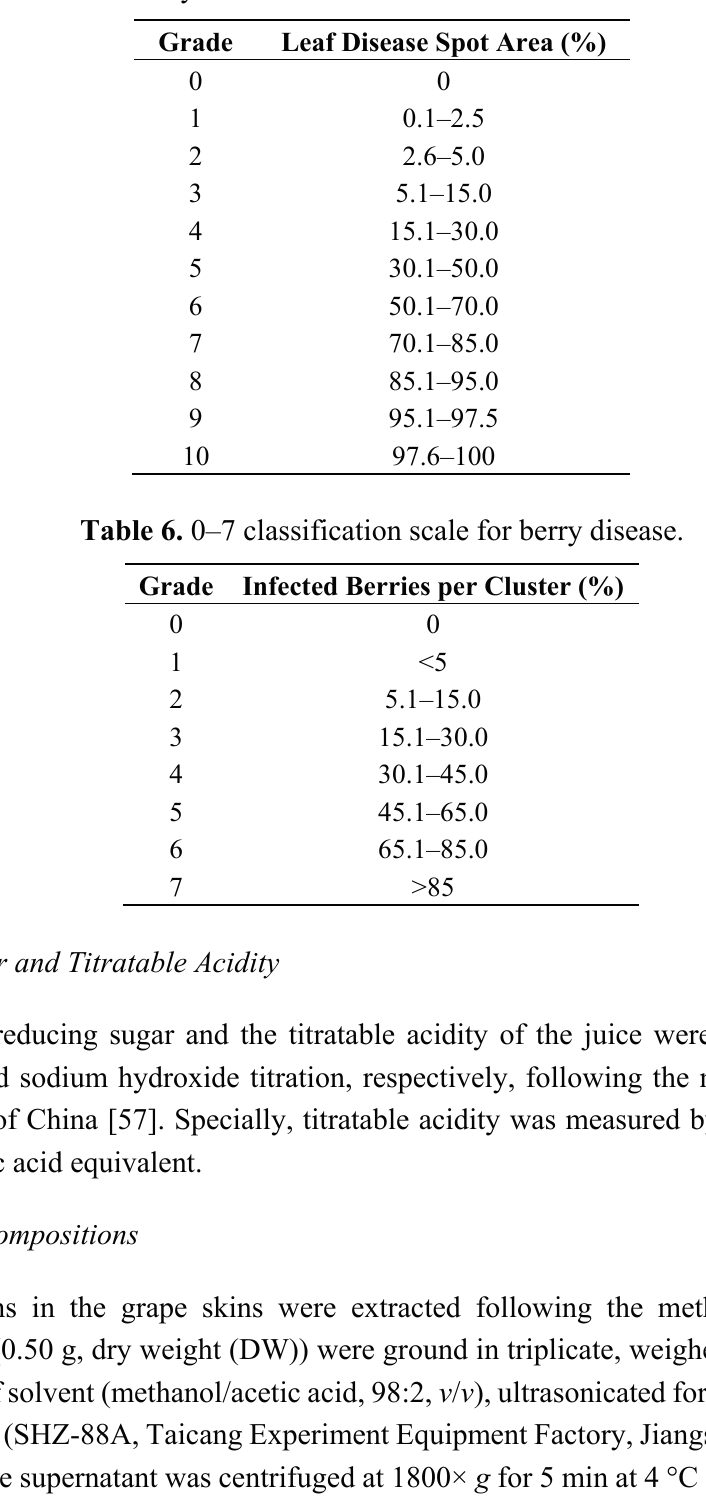
Table 5. Desaymard 0–10 classification scale for leaf disease.